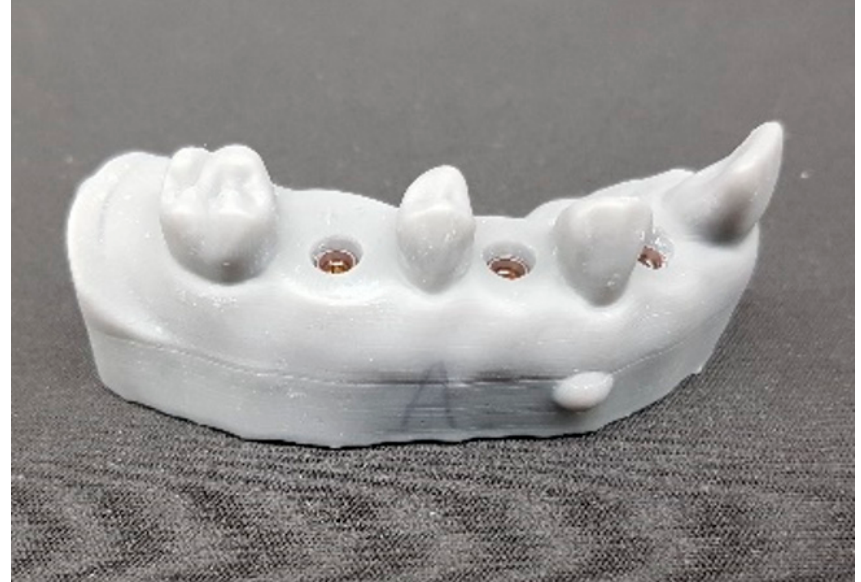
Figure 2. Designed and printed master model.